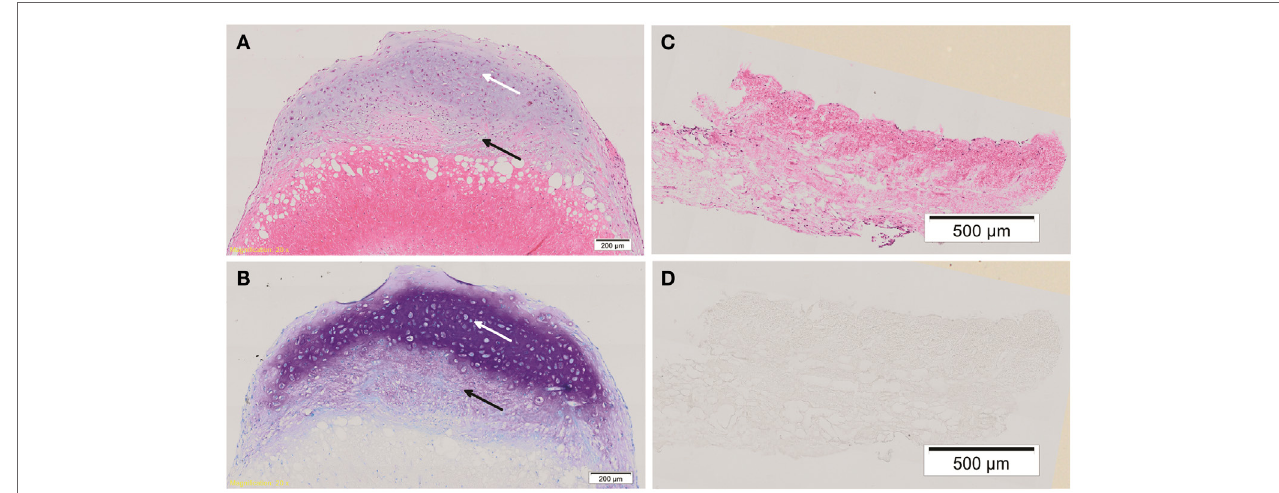
FigUre 3 | histology of cell-aDM constructs. Representative histological figures of H&E and toluidine blue (TB) staining are shown for week 4 chondrogenic (a,B) and control (c,D) IPFP-ASCs on ADM. Chondrogenic cell-ADM constructs show cells within the cartilaginous cap displaying chondrocytic morphology and strong staining for TB indicative of the presence of proteoglycans (white arrow). There is also cellular infiltration within the ADM. Cells of a mixed morphology can be seen within the “ADM-cell interaction zone” (black arrow). No evidence of chondrogenic features could be detected in the control group. Scale bars as indicated. Magnification: 10 ×